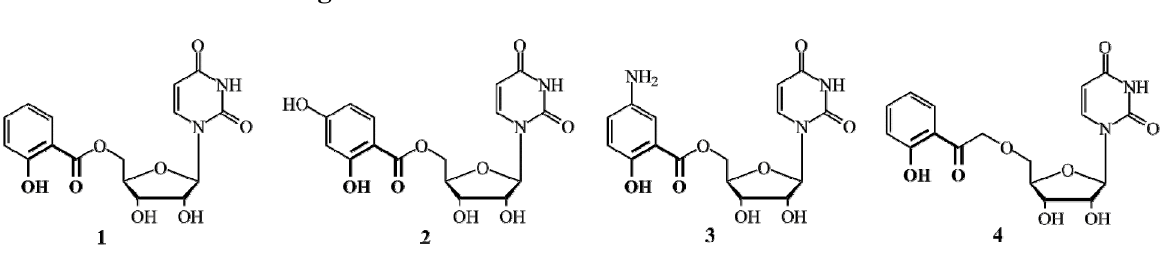
Figure 2. C-5 ′ modified uridine derivatives 1 – 4